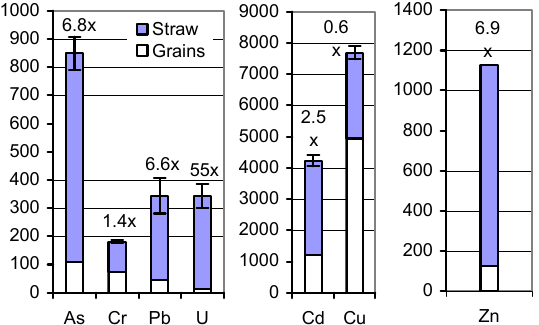
Figure 3. Absolute amounts (mg; Zn in g) and proportions (values heading the columns) of the heavy-metal toxicants in soil-A grown straw (0.984 Mg) and in the associated grains of cv. JB Asano (1 Mg) at maturity. Refer to soil-A values in Table 1. The dark columns sections do not refer to the zero axis. Error bars show the ± SD values for straw. Agriculture 2016 , 6 , 51